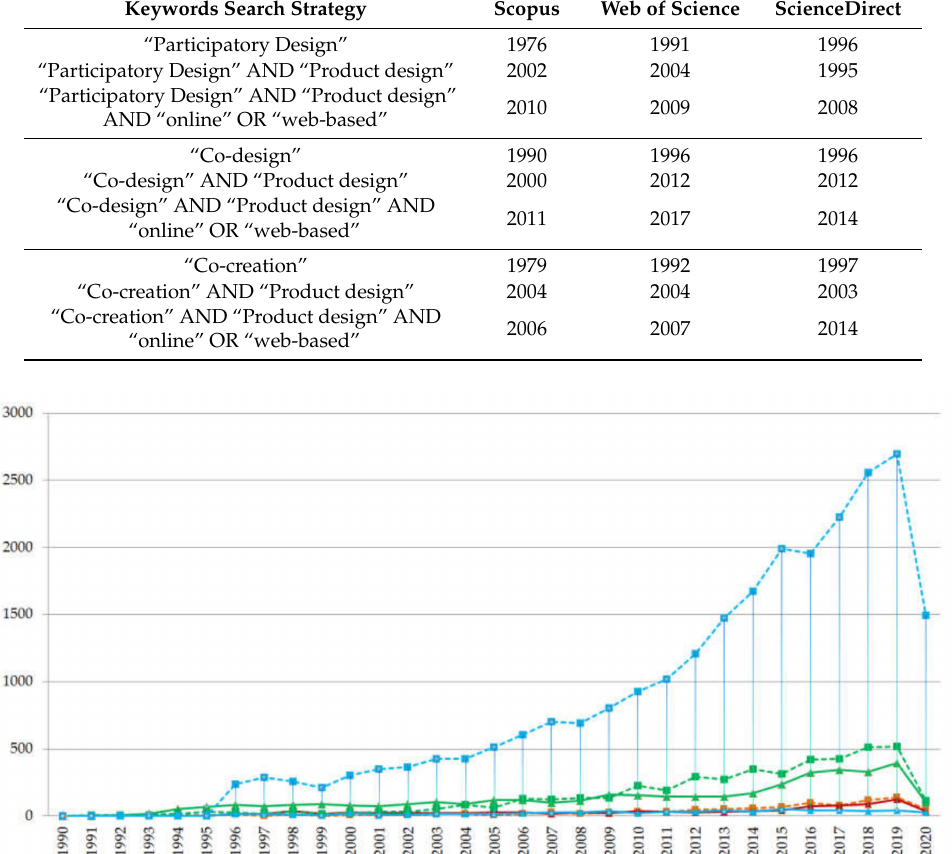
Figure 2. Timeline and number of publications related to co-design. Table 2. Use of di ff erent keyword combination search strategies to get the earliest years of relevant literature in the three databases.